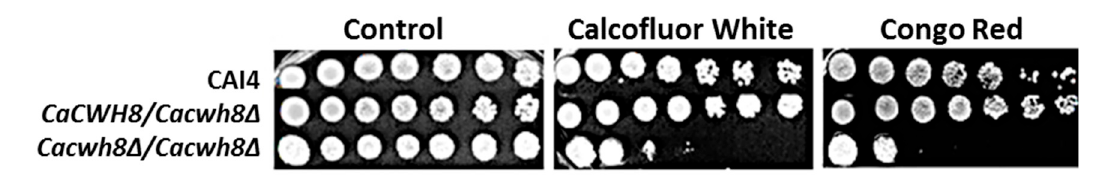
Figure 10. Sensitivity of the wild type C. albicans strain CAI4 and the CaCWH8 mutants to Calcofluor White and Congo Red.